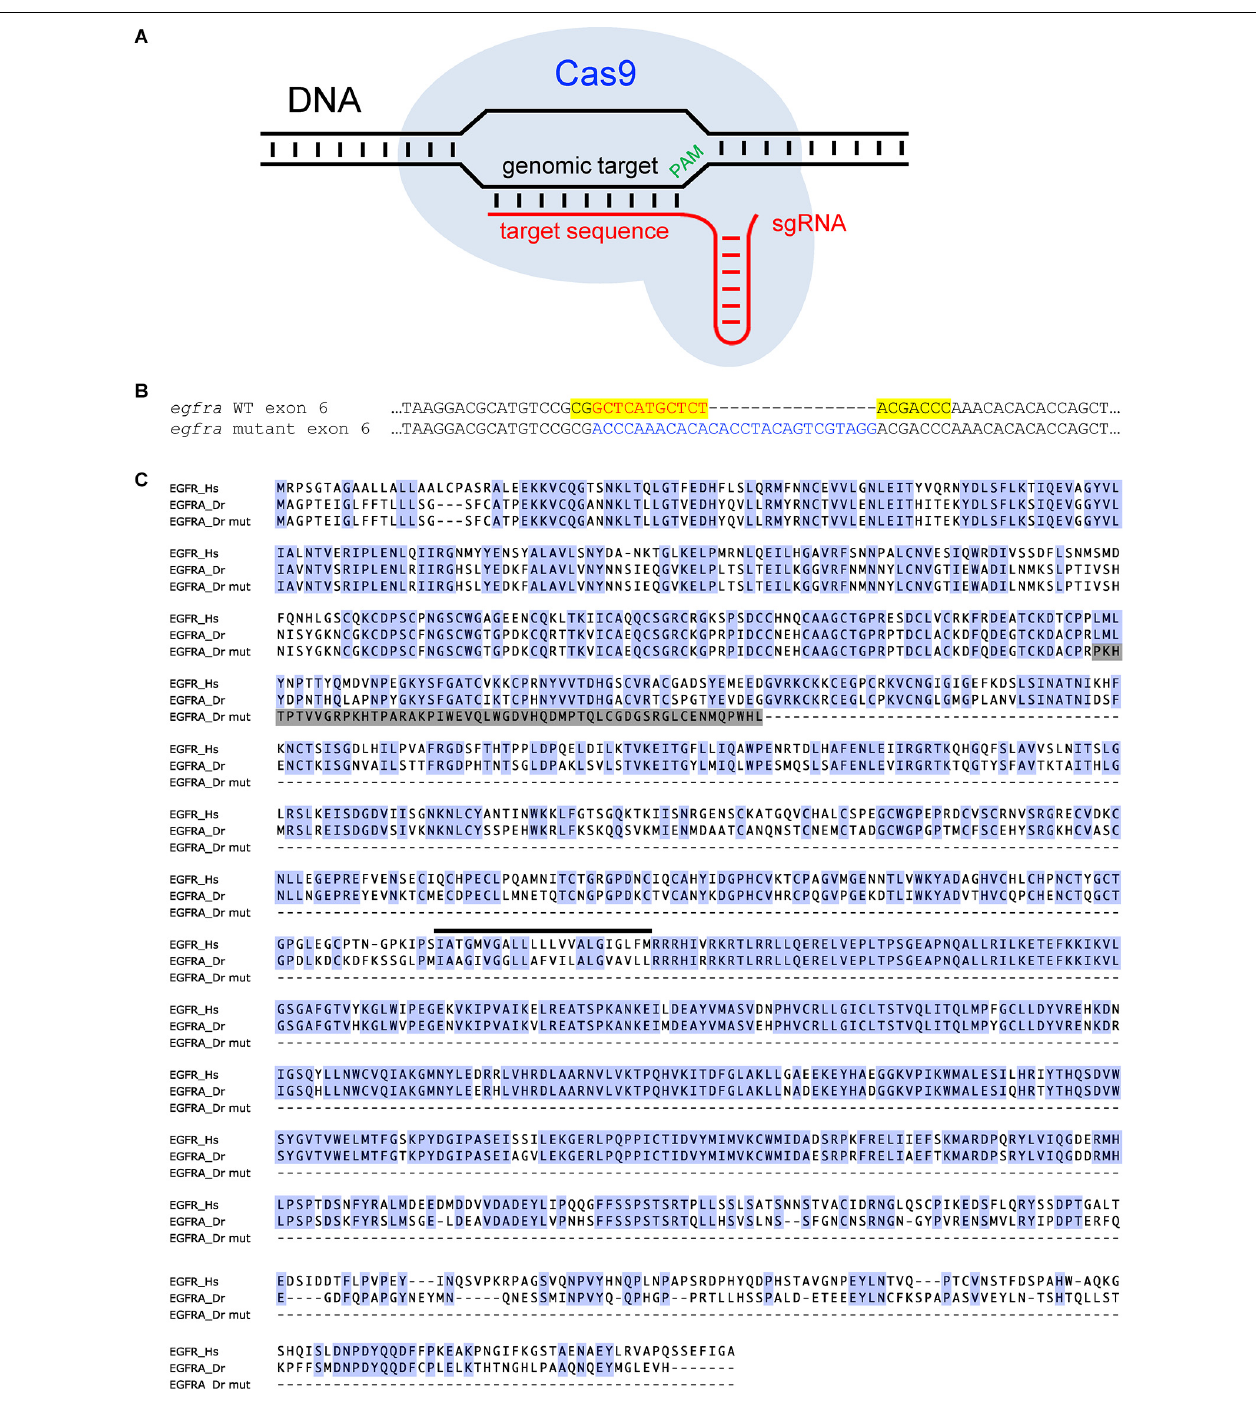
FIGURE 3 | Using CRISPR/Cas9 to generate a predicted null mutation in the zebrafish egfra gene. (A) A schematic diagram of the CRISPR/Cas9 system. The Cas9/sgRNA complex targets a specific sequence in the genome based on a 20 base-pair target sequence in the sgRNA that is complementary to the genomic target next to a protospacer adjacent motif (PAM) and produces a double-stranded DNA break. (B) The coding sequence of a region of exon 6 from WT and mutant zebrafish egfra are shown. The mutant contains an 11 bp deletion (red font) and a 27 bp insertion (blue font) in the egfra gene. Yellow shading indicates the sgRNA target sequence. (C) An alignment of human EGFR (Hs), zebrafish WT EGFRA (Dr), and zebrafish mutant EGFRA (Dr mut) proteins is shown. Blue shading indicates amino acids that are identical in the human and zebrafish orthologs. Gray shading indicates frame shifted sequence in the zebrafish EGFRA mutant. The black line indicates the location of the transmembrane domain in the WT proteins. The mutant protein lacks the transmembrane domain and intracellular domains that are required to interact with downstream effector proteins, and thus should be non-functional. Reproduced and modified from Lee et al. (2019).